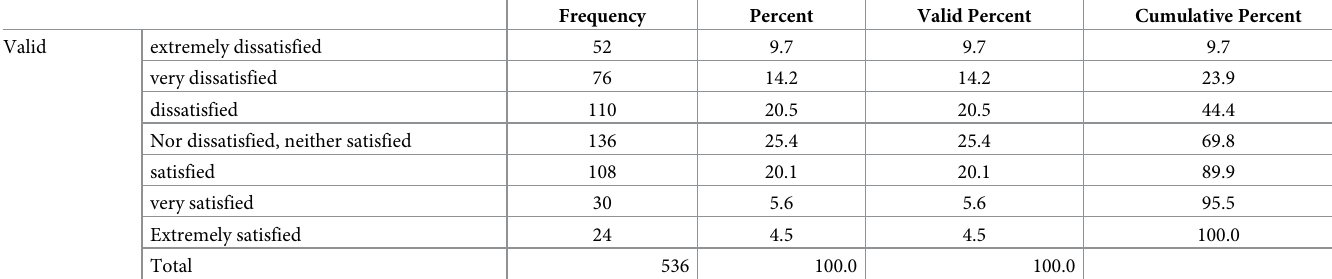
Table 5. The level of satisfaction with the way information about drugs used to treat the virus were communicated at national level.